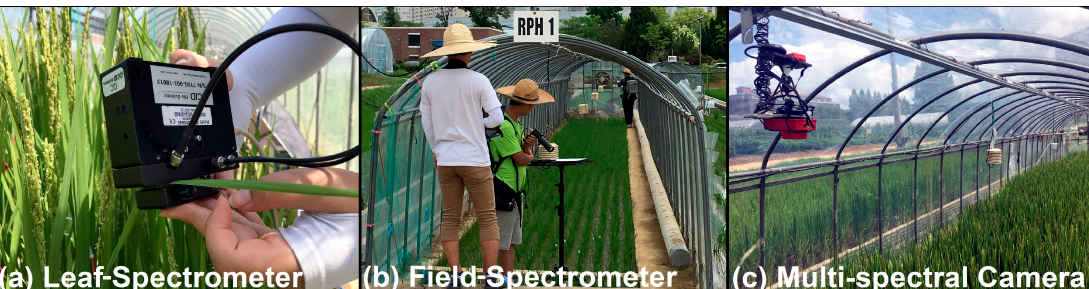
Figure 2. Observation images of optical devices such as ( a ) leaf ‐ spectrometer, ( b ) field ‐ spectrometer, and ( c ) multi ‐ spectral camera.